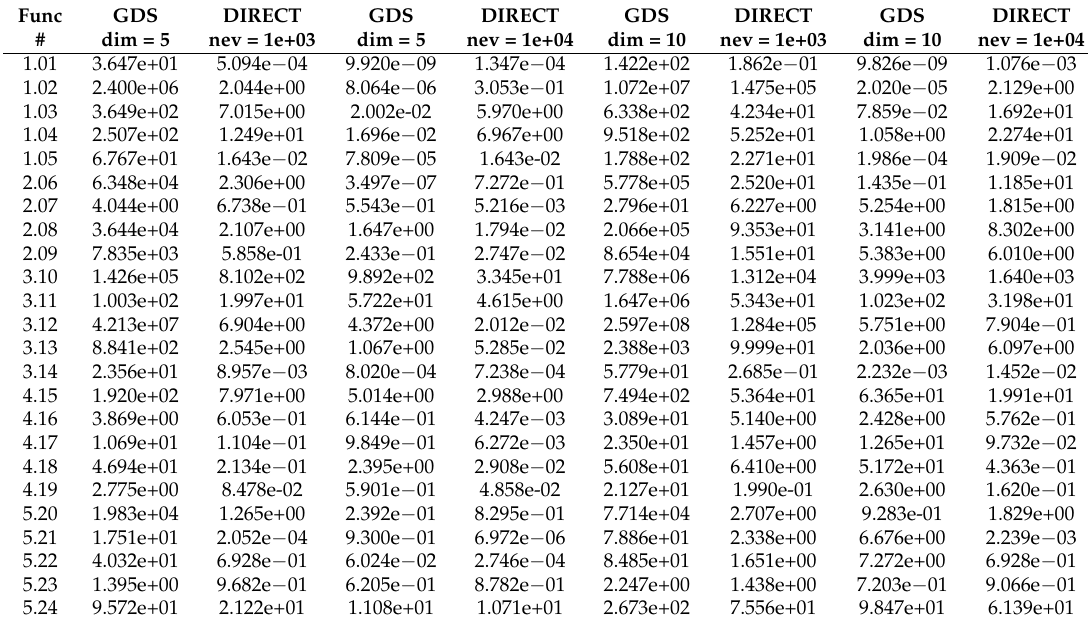
Table 2. Comparative study of the median of the error for problems of dimensions 5 and 10 and the number of evaluations 1e + 03 and 1e + 04.